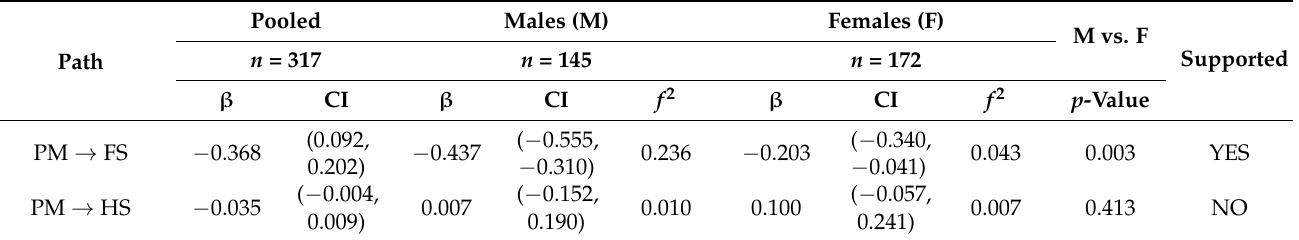
Table 7. Results of the multi-group